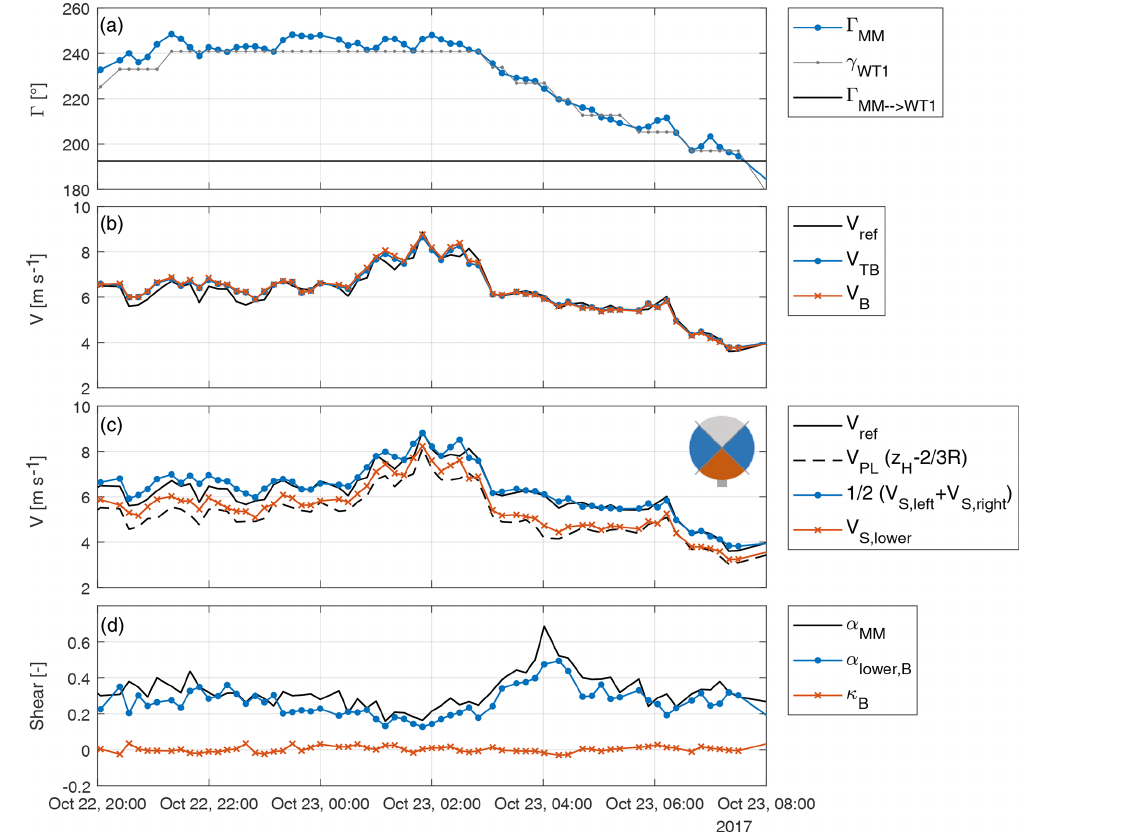
Figure 7. Time series reporting met-mast wind direction and turbine yaw orientation (a) , met-mast and estimated rotor-effective wind speeds (b) , speeds at different heights (c) , and met-mast and estimated vertical and horizontal shears (d) .